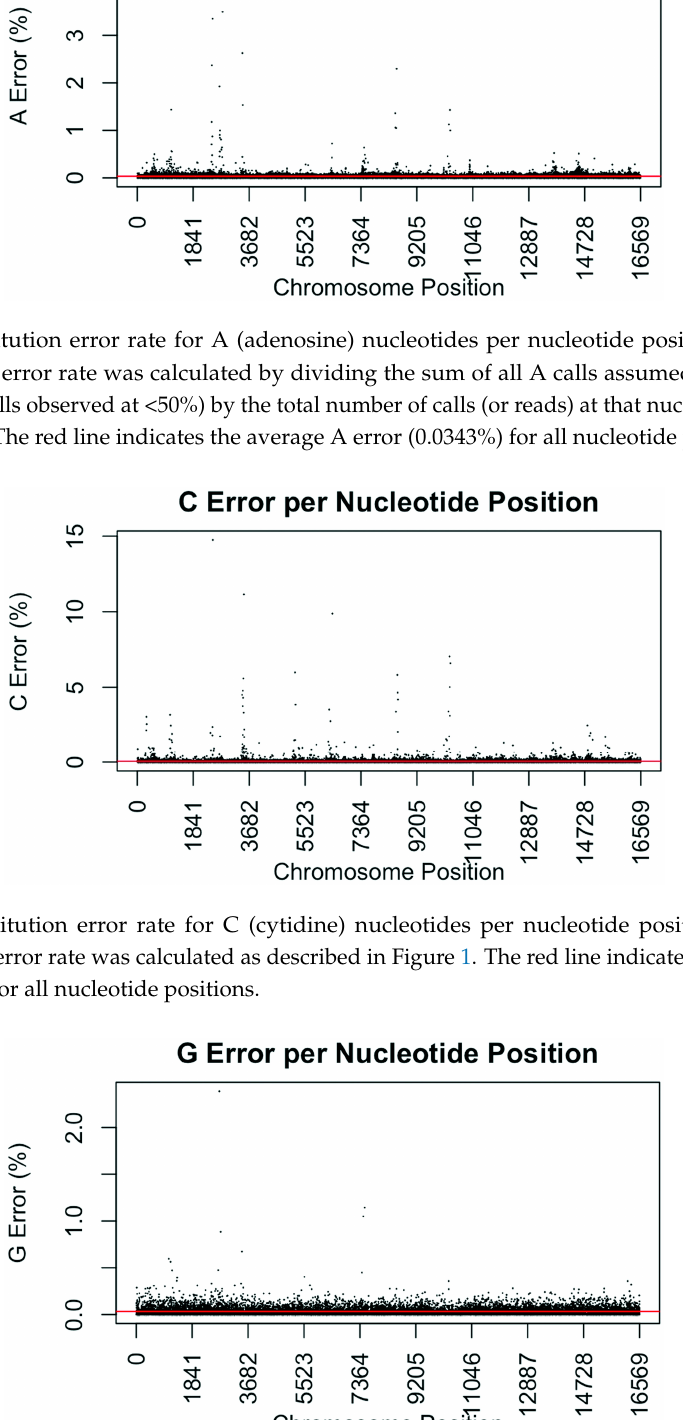
Figure 3. Substitution error rate for G (guanosine) nucleotides per nucleotide position across the mtDNA genome. The error rate was calculated as described in Figure 1. The red line indicates the average G error (0.0331%) for all nucleotide positions.